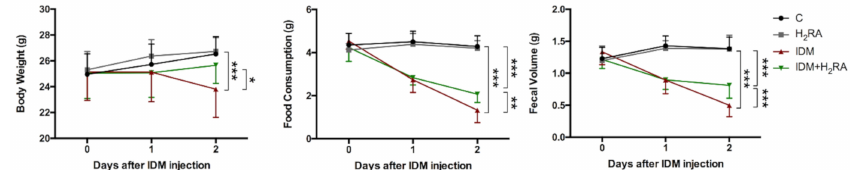
Figure 1. Biological changes in Indometacin (IDM)-induced intestinal mucosal injury model with or without histamine H 2 -receptor antagonists (H 2 RA) administration. Fifty mice (16 control, 5 H 2 RA only, 13 IDM, and 16 IDM + H 2 RA mice) were administered a single dose of IDM and were administered H 2 RA daily. From the first day of IDM administration, defined as day 0, body weight, food intake, and fecal volume were measured daily. Statistical analysis was performed using two-way analysis of variance (ANOVA) with Tukey’s post-hoc test. * p < 0.05, ** p < 0.01, *** p <